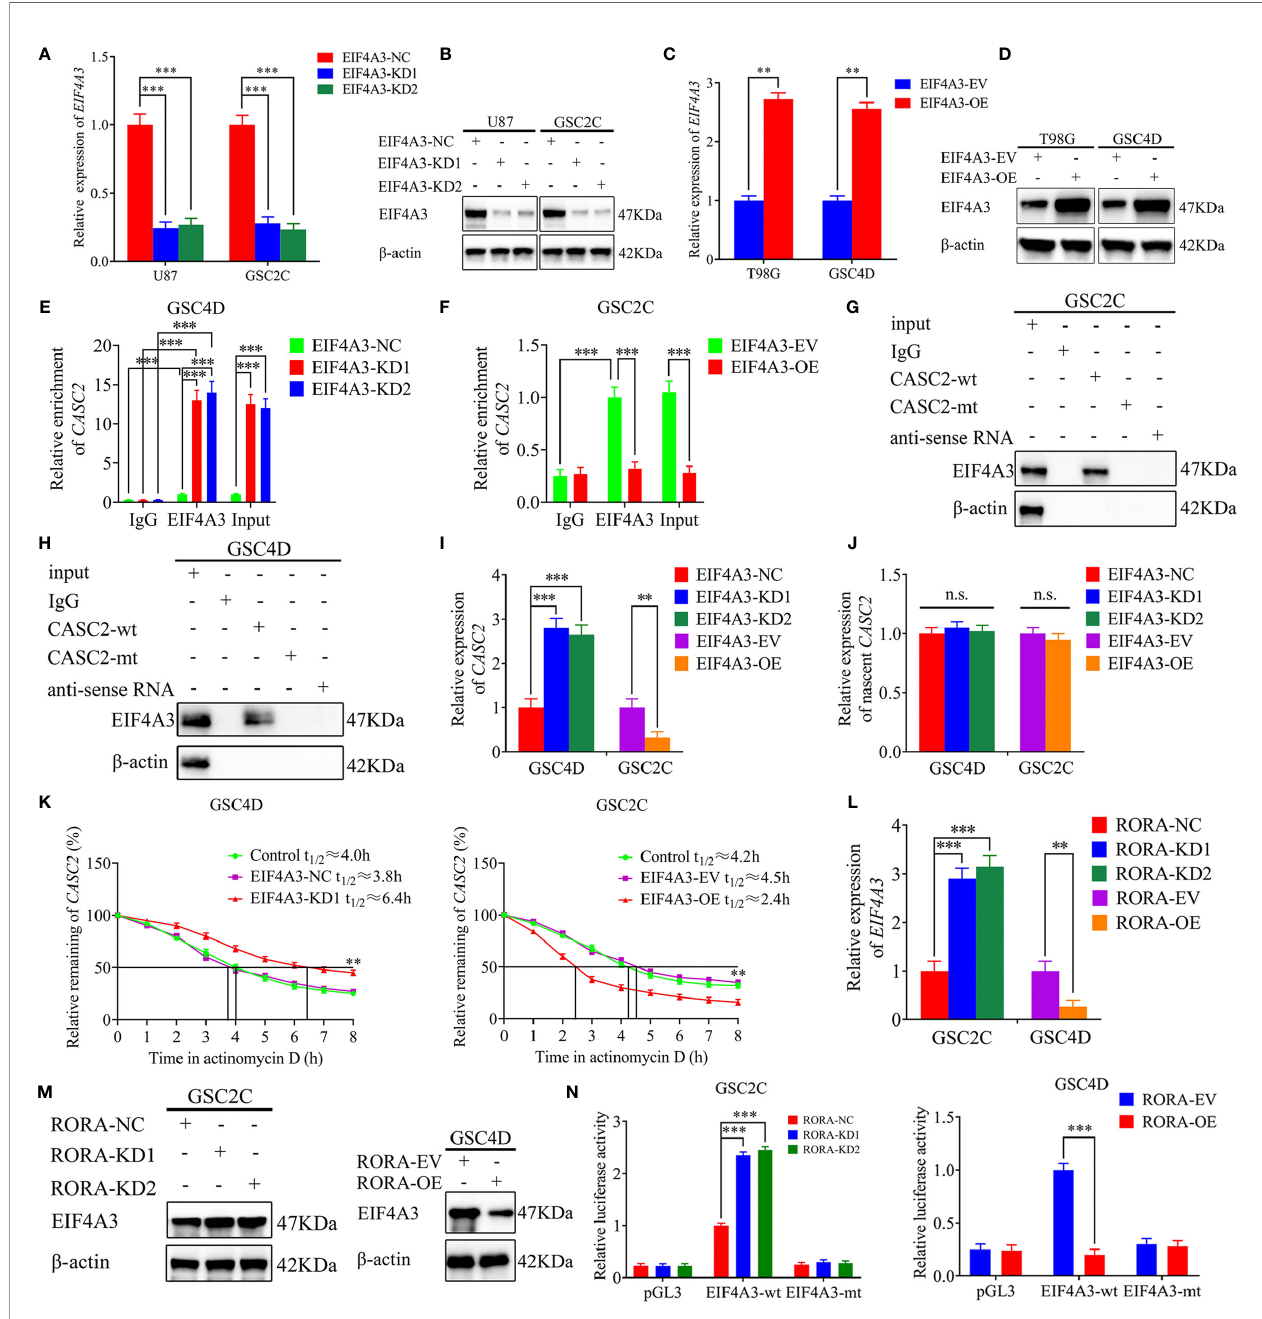
FIGURE 6 | EIF4A3 downregulates the expression of CASC2 via inducing its cleavage, while RORA transcriptionally regulates the expression of EIF4A3. (A – D) qPCR (A, C) and western blotting (B, D) showing the validation of EIF4A3 knockdown or overexpression. (E, F) The RNA immunoprecipitation (RIP) assay was performed in GSC4D or GSC2C after EIF4A3 knockdown or overexpression, and negative control was transfected, followed by q-PCR to detect the enrichment of CASC2 and EIF4A3. (G, H) The RNA pull-down assays showed the EIF4A3 protein immunoprecipitation with CASC2 as detected by western blotting. (I) RT-qPCR showing the expression of CASC2 after EIF4A3 knockdown or overexpression. (J) The nascent CASC2 was detected by RT-qPCR. (K) Graphs showing CASC2 levels at different times treated by actinomycin D in GSC4D and GSC2C. (L) RT-qPCR showing the expression of EIF4A3 after RORA knockdown or overexpression. (M) Western blotting showing the expression of EIF4A3 protein in RORA-silenced GSC2C and RORA-overexpressed GSC4D. (N) The luciferase reporter assays showed that RORA knockdown or overexpression affected the luciferase activities of EIF4A3 in GSCs. EV, empty vector; OE, overexpression; NC, negative control; KD, knockdown. All data are expressed as the mean ± SD (three independent experiments). **P < 0.01; ***P < 0.001; n.s., not signi fi